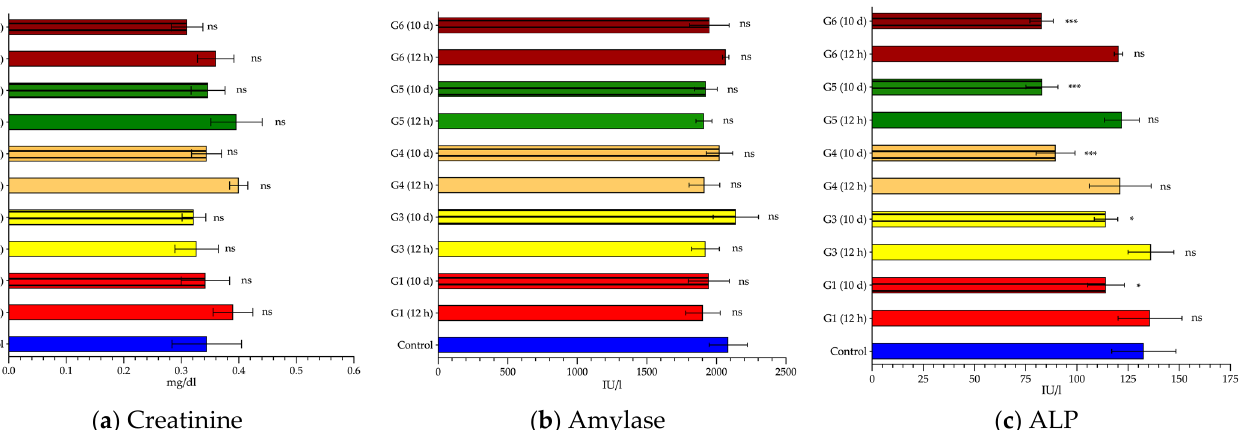
( b ) LDH Figure 5. Serum values of ubiquitous enzymes. Creatine kinase (CK) ( a ), lactate dehydrogenase